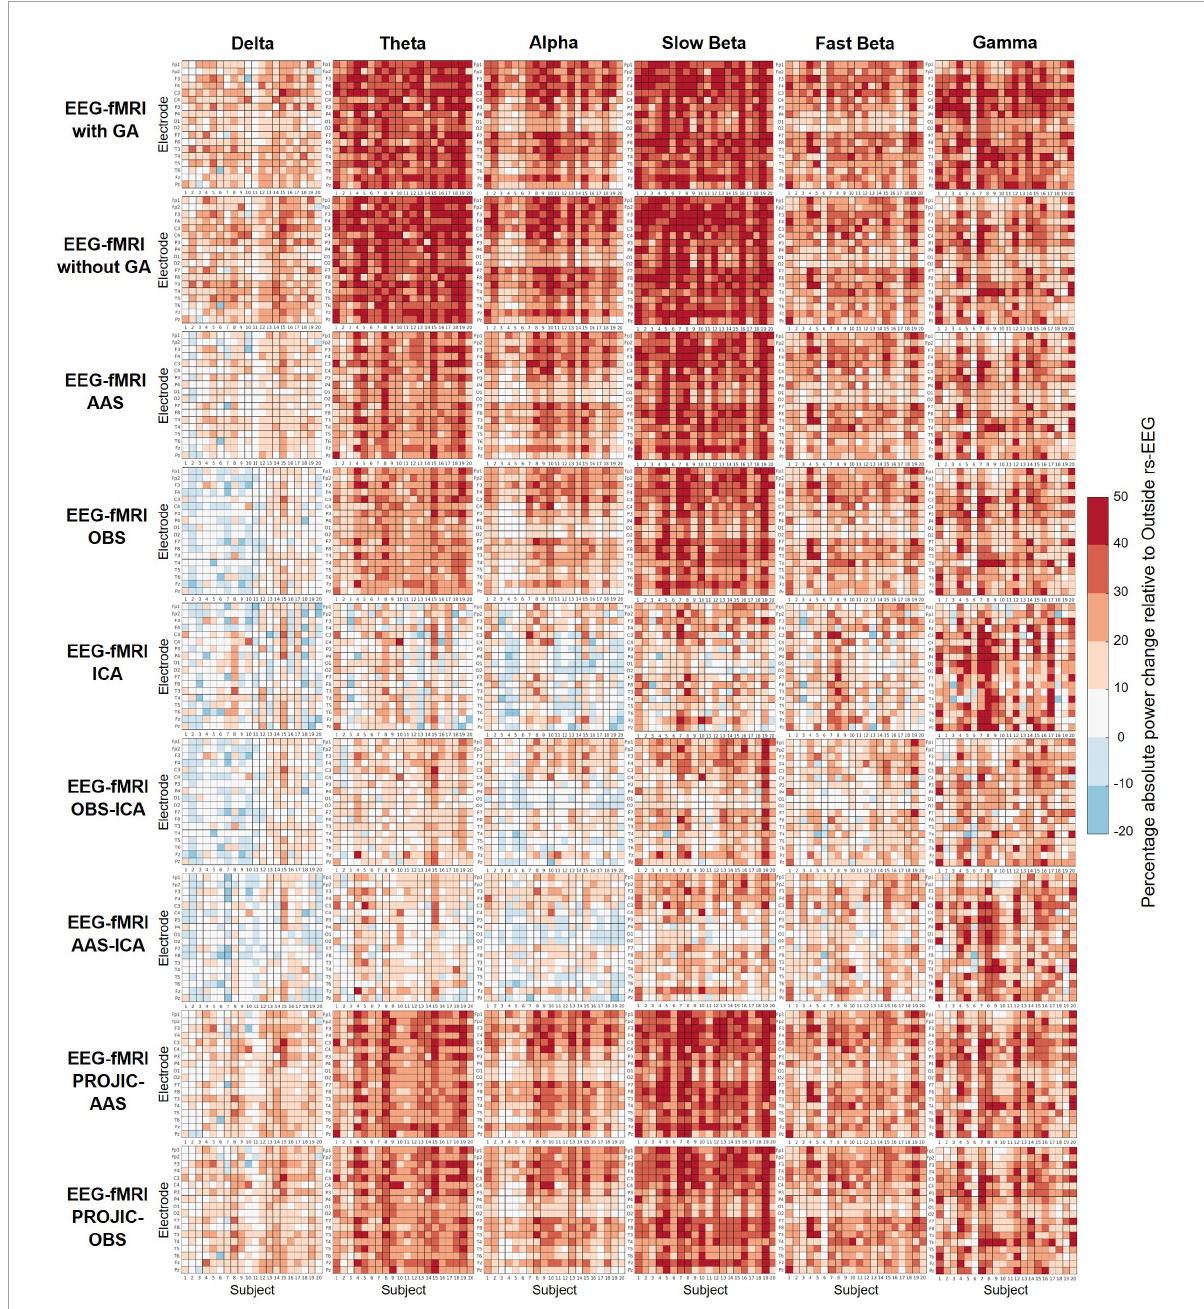
FIGURE2 Percentage change (colorbar) in the absolute power of each frequency band of the rs-EEG-fMRI data before and after BCG artifact removal, relative to the Outside rs-EEG. Each matrix shows all electrodes (rows) for each subject (columns). A negative percentage indicates lower absolute power in the rs-EEG-fMRI compared to the outside rs-EEG. ICA-based corrections performed better in reducing the BCG artifact contribution and preserving the rs-EEG-fMRI spectral profile (especially for delta, theta, and alpha bands), though artifact residuals and/or absolute power decreases were evident for most subjects, across all frequency bands.